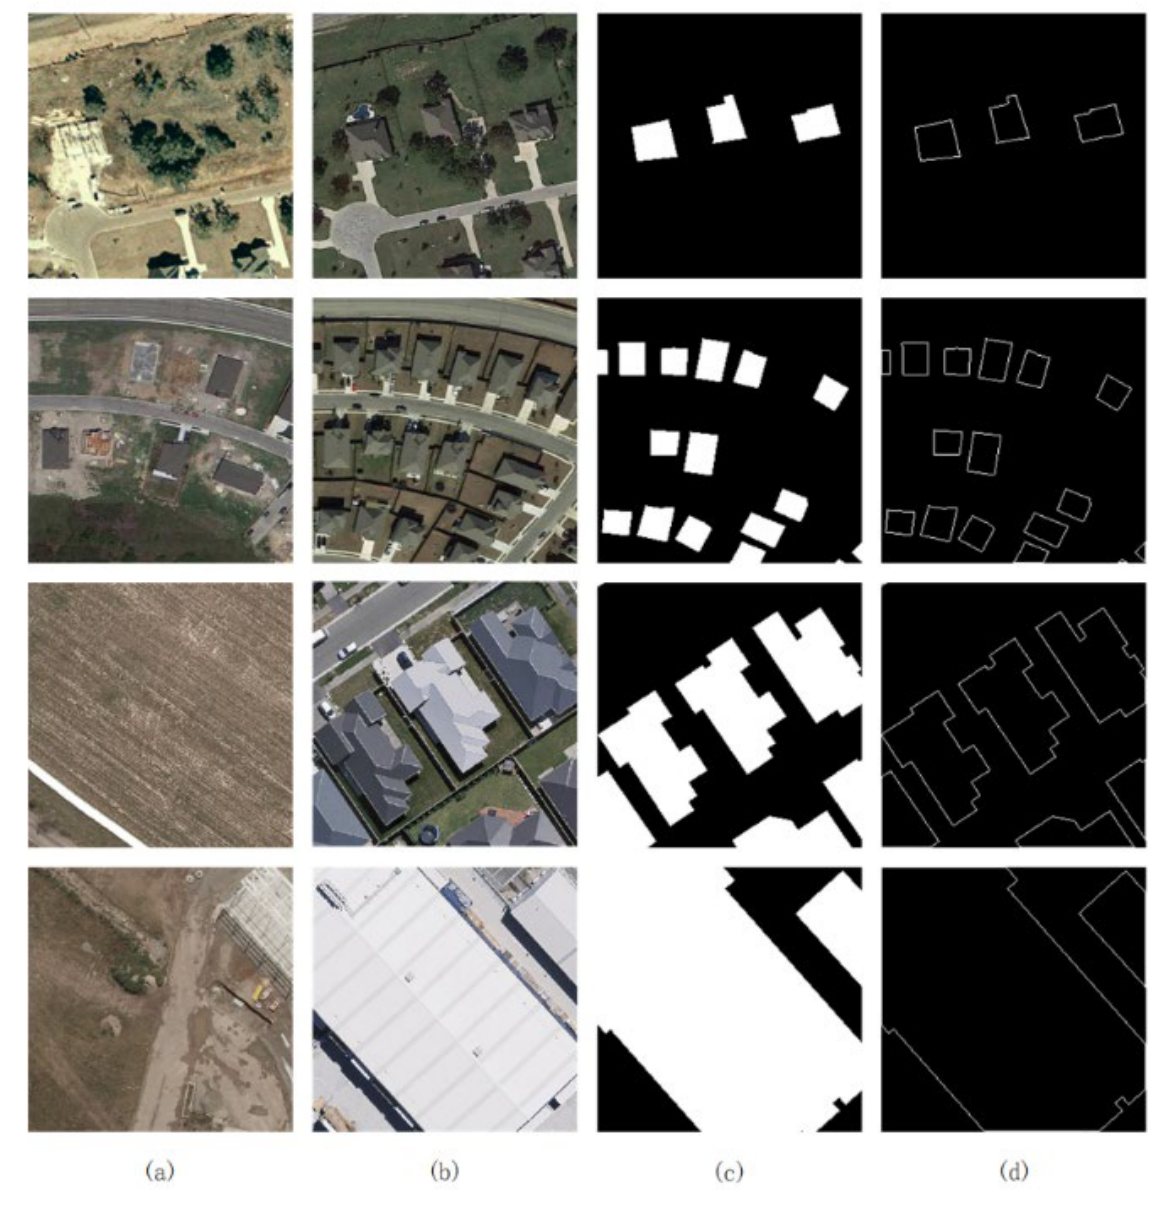
Figure 8. The first and second rows show cropped examples of the LEVIR-CD dataset, and the third and fourth rows show cropped examples of the WHU dataset. ( a ) Images before the change. ( b ) Images after the change. ( c ) Change label. ( d ) Change edge label. The images in ( d ) are generated using the Canny edge detection operator on the images in ( c ).